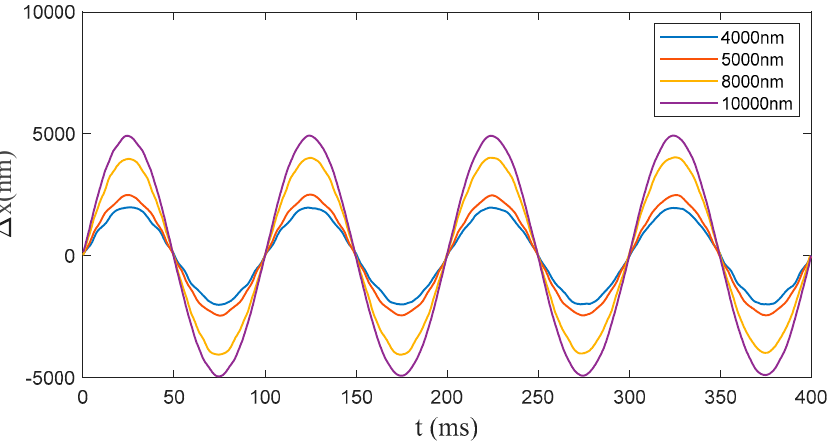
Figure 7. Reconstructed results of the sinusoidal motion of grating only in X -direction with amplitude (p–p) at 4000 nm, 5000 nm, 8000 nm, and 10,000 nm. Table 1. Measurement results of in-plane displacement Δ x.